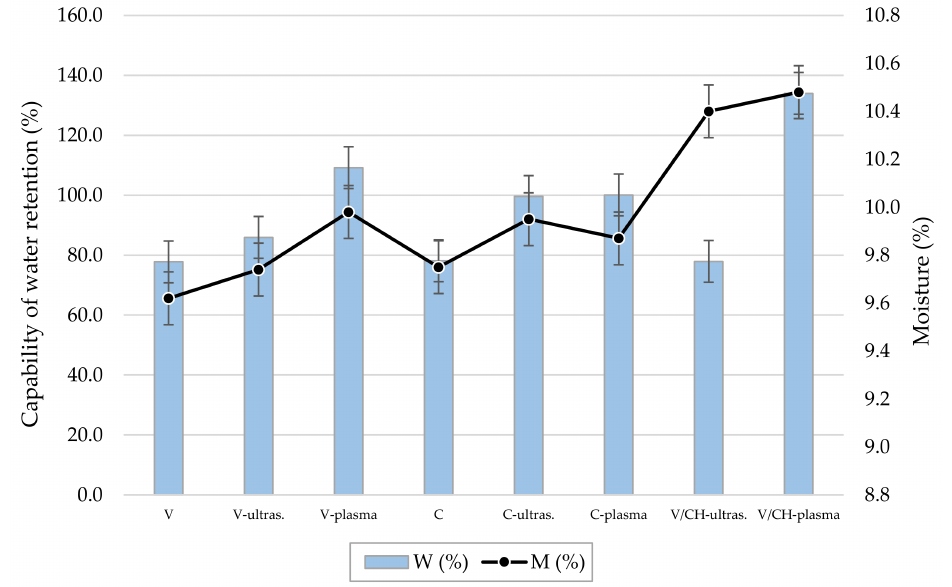
Figure 3. Moisture sorption ( M ) and capability of water retention ( W ), for all tested fibers, with the standard